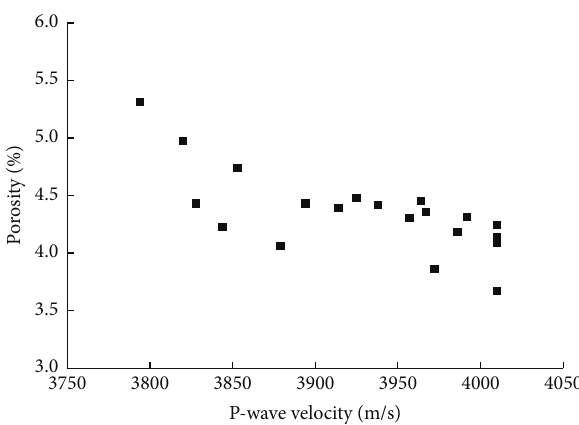
Figure 4: Relationship between porosity and P-wave velocity of granite specimens under different chemical solutions.